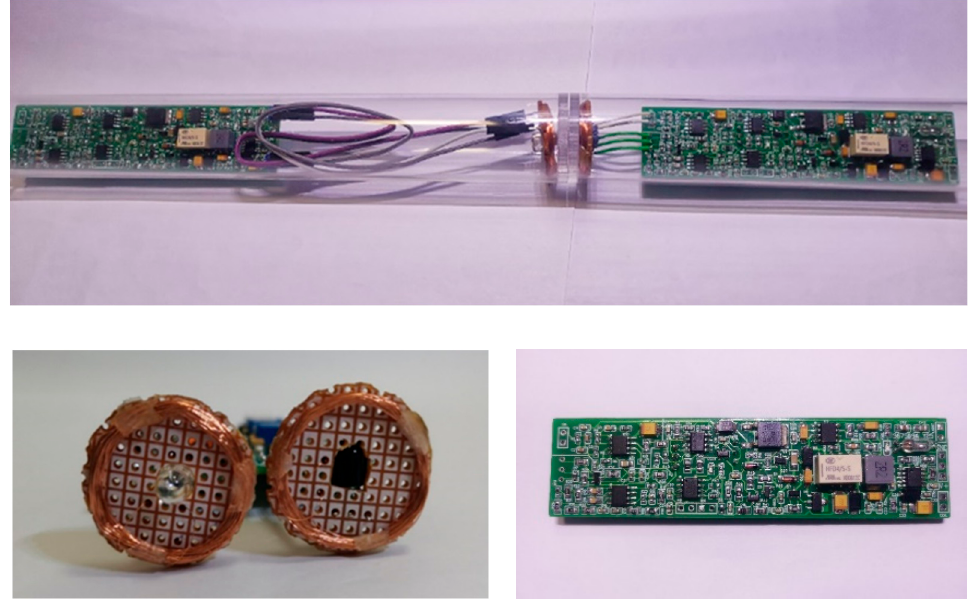
Figure 18. Image showing the relay node.